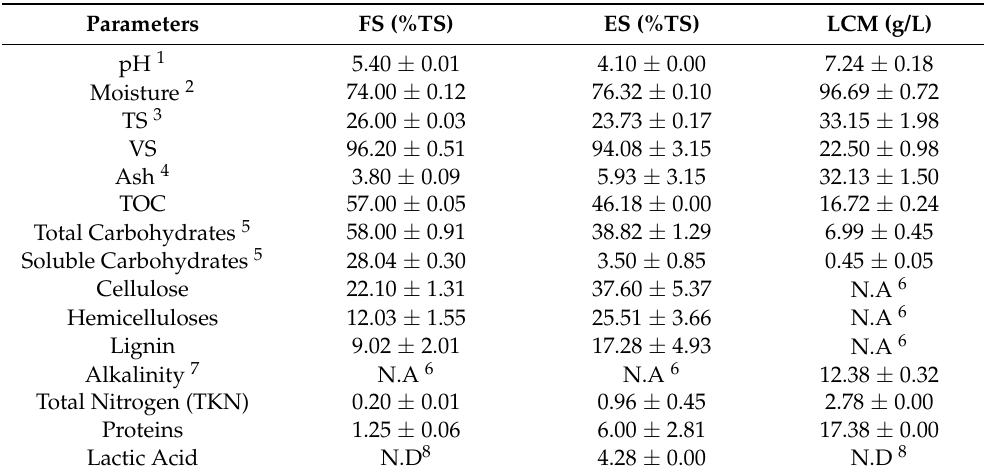
Table 1. Physicochemical characterization of FS, ES, and LCM. The values correspond to mean ± standard deviation of measurement analysed in duplicate. The parameter units are presented on the top of the table next to each substrate, with exceptions in the footnotes below the table.